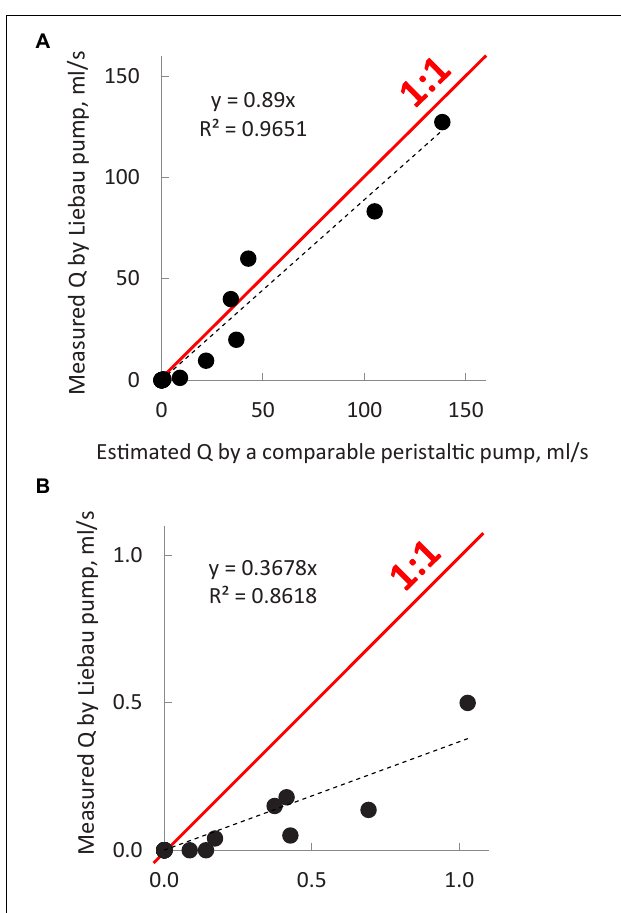
FIGURE 3 | Output of Liebau pumps in comparison to peristaltic pumps of the same dimensions. The graphs were compiled using MS Excel from published studies listed in Table 2 . They illustrate the relative efficiency of Liebau pumps compared to peristaltic pumps of the same dimensions and compression frequencies. Dots above the red line indicate flow rates that were higher than the ones created by the peristaltic pumps; below the red line are lower. For macroscopic pumps, flow created by Liebau pumps was ∼ 90% from that of peristaltic flow, while for smaller pumps it was ∼ 40%. Data also point to a significant correlation between the two ways to pump fluid. To calculate the output of a comparable peristaltic pump, the cross-sectional area of the tube was multiplied by the width of the pincher element and the compression frequency at which the maximal flow was observed in each cited study of the Liebau pump. Red rectangle in (A) encompasses datapoints for micropumps. The latter has been shown in (B) using different